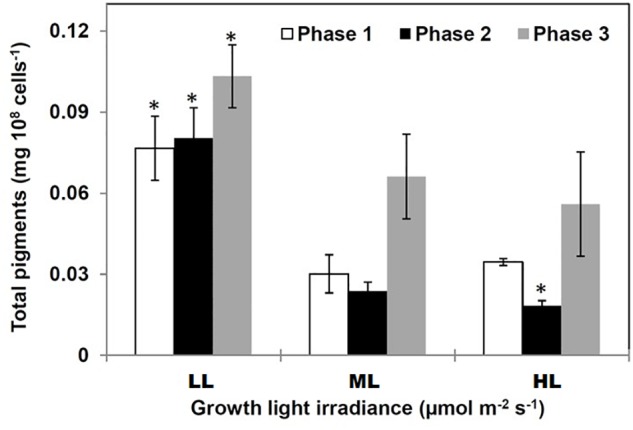
Total pigments in Phaeodactylum tricornutum grown under different light intensities. Pigment accumulated in diatoms in two growing conditions: (1) under LL (regardless the growth phase) and in phase 3 (regardless the growth photon flux density). Data are mean values ± SE (n = 3) and error bars represent SD. Means followed by asterisks are significantly different from the corresponding value in ML (p < 0.05, student’s t-test).